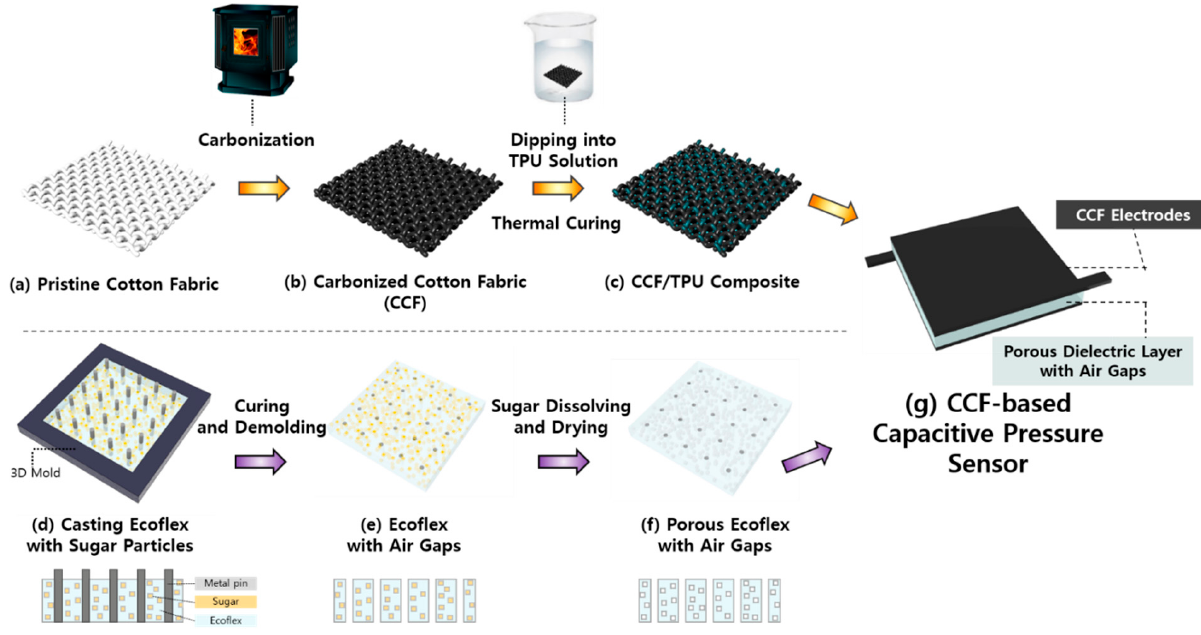
Figure 1. Manufacturing process of carbonized cotton fabric (CCF)-based capacitive pressure sensors: ( a – c ) fabrication of CCF electrodes; ( d – f ) fabrication of a porous dielectric layer with air gaps; ( g ) developed capacitive pressure sensor using CCF electrodes and a porous dielectric layer with air gaps.